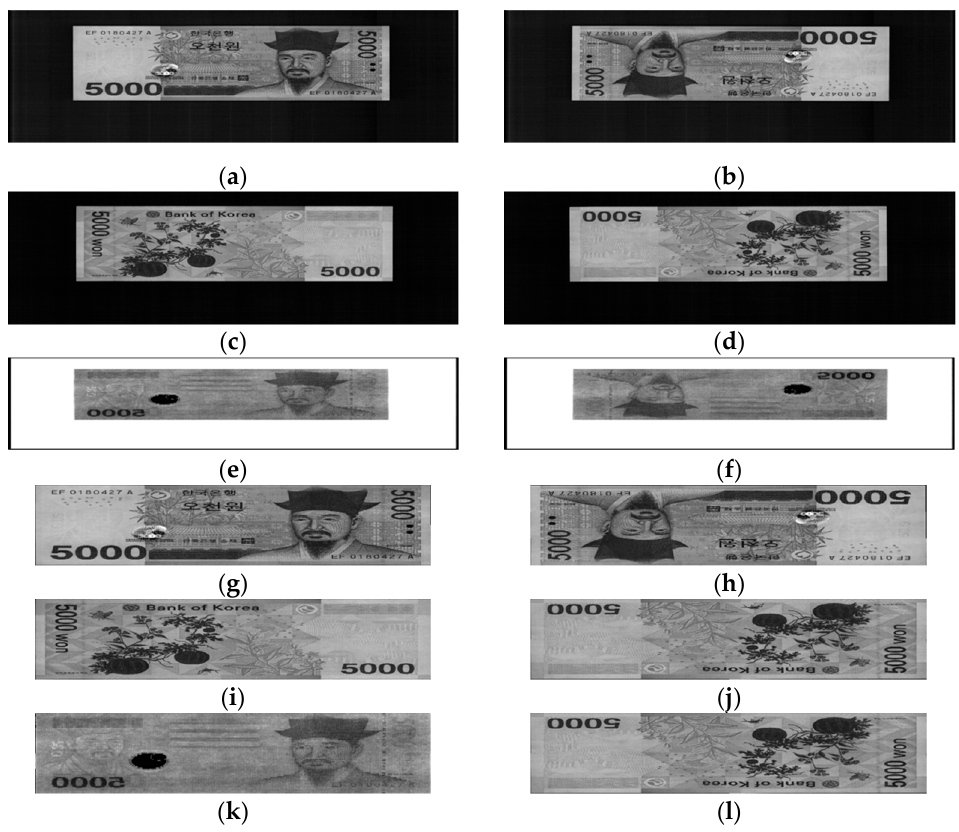
Figure 2. Example of KRW banknote images captured by the device in: ( a ) front side’s forward VR image (A direction); ( b ) front side’s backward VR image (B direction); ( c ) back side’s forward VR image (C direction); ( d ) back side’s backward VR image (D direction); ( e ) forward IRT image and ( f ) backward IRT image; ( g – l ) are the corresponding banknote region segmented images from the original images in ( a – f ), respectively.